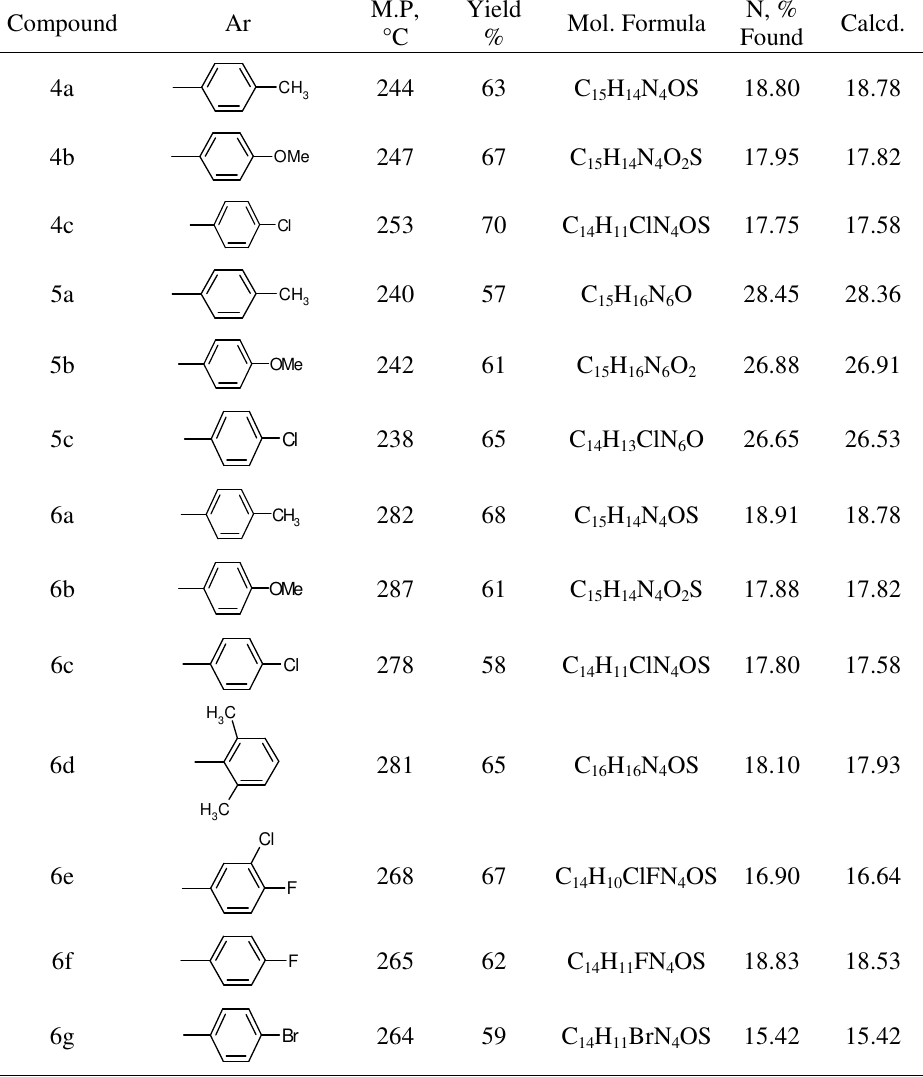
Table 1. Characterization data of the